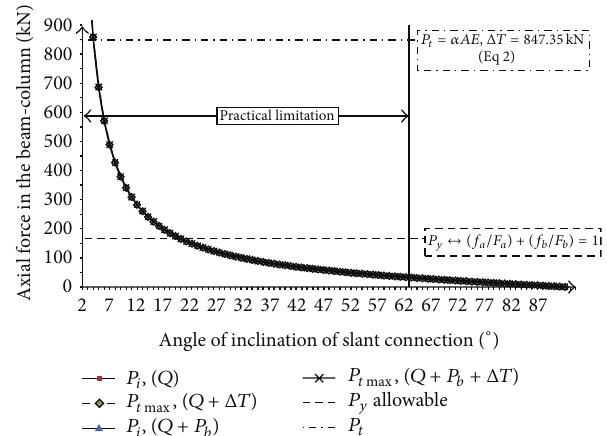
Figure 16: Relation between axial force in the beam with slope of slant connection ( 𝜃 ∘ ) due to nonsymmetric gravity load and elevated temperature (friction factor, 𝜇 𝑠 = tan 𝜑 = 0 ) (Δ𝑇) = 50 ∘